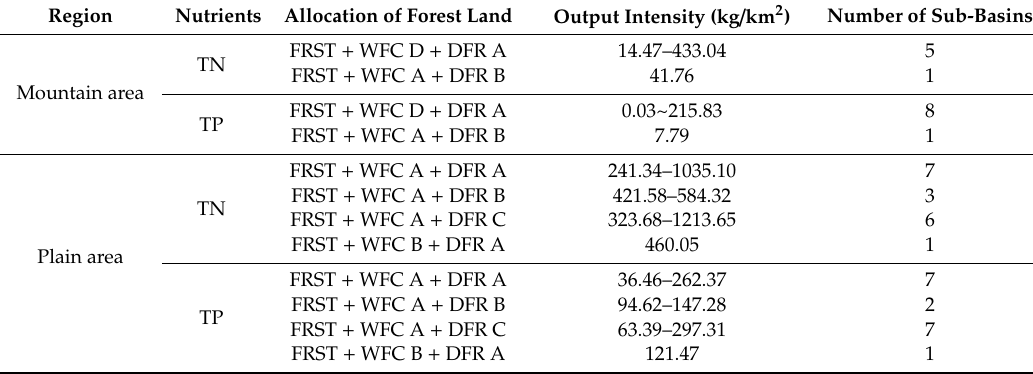
Table 7. Status of forestland allocation in low-intensity sub-basins with TN and TP output in mountainous and plain areas.